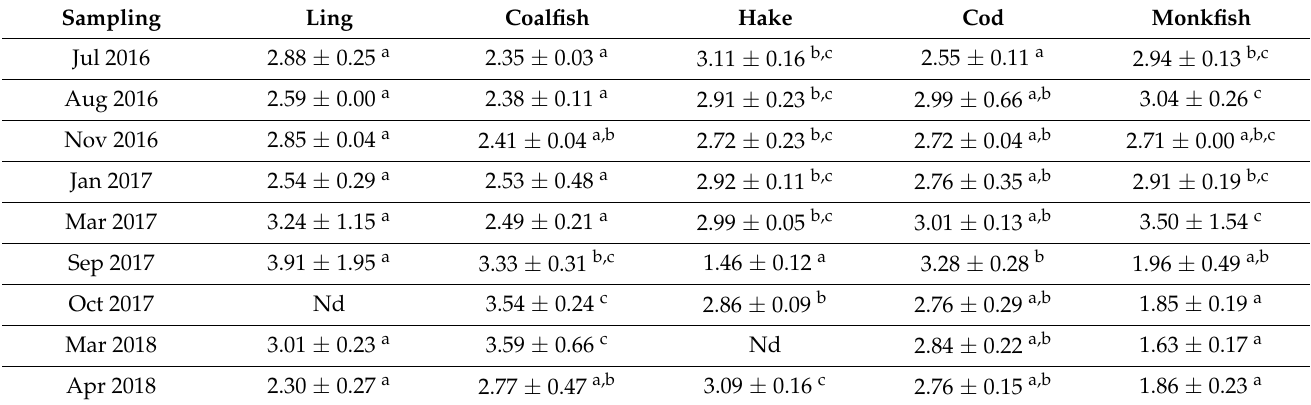
Table 4. Sum of omega-6 PUFA (%) in fish livers sampled at different time